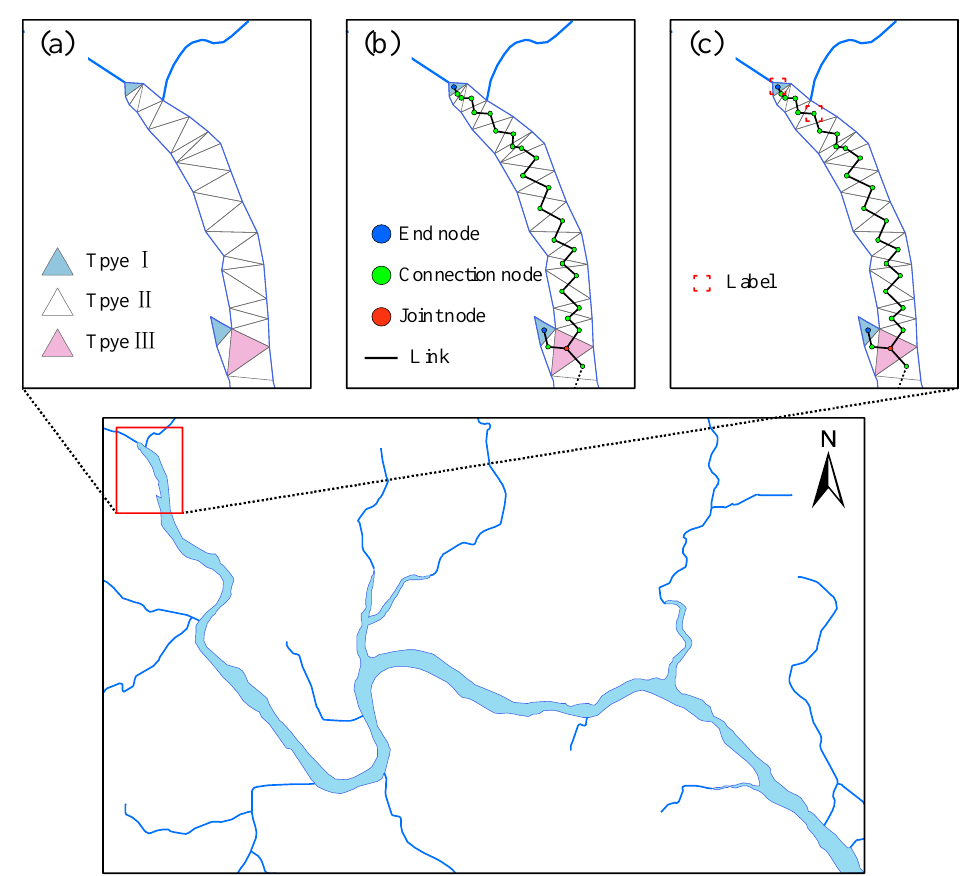
Figure 2. Structured mode of dual-line rivers: ( a ) constrained Delaunay triangulation construction and triangle classification; ( b ) skeleton graph construction; ( c ) skeleton graph labelling.